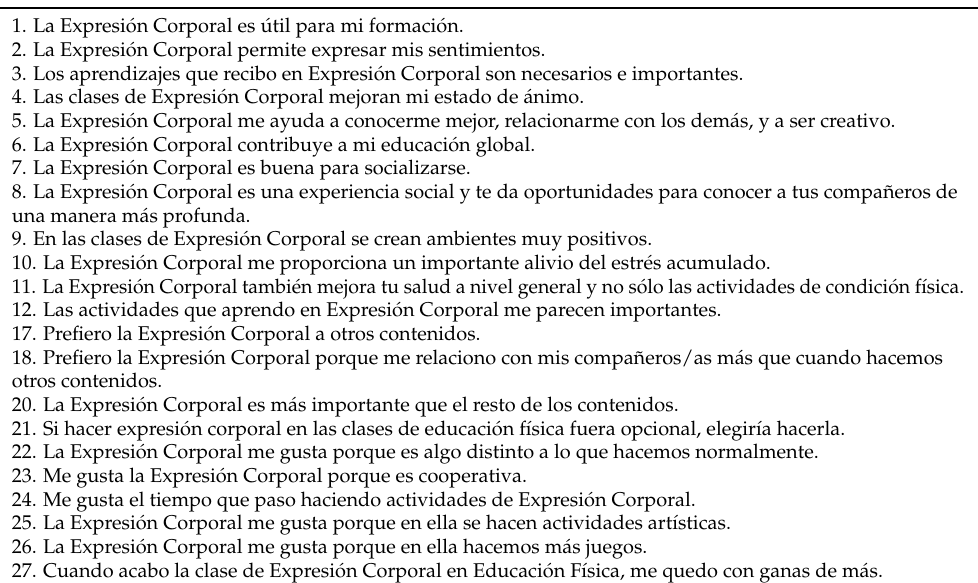
Table A1. Cuestionario para la Evaluaci ó n de la medida de las actitudes hacia la Expresi ó n Corporal. Reprinted from ref.